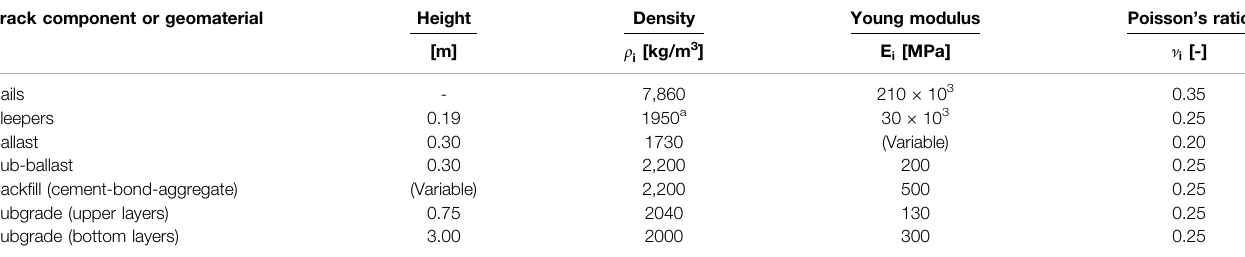
TABLE 1 | Properties of the materials of the track and its substructure (Bowles, 1997; Fortunato et al., 2012; Paixão 2014). Track component or geomaterial